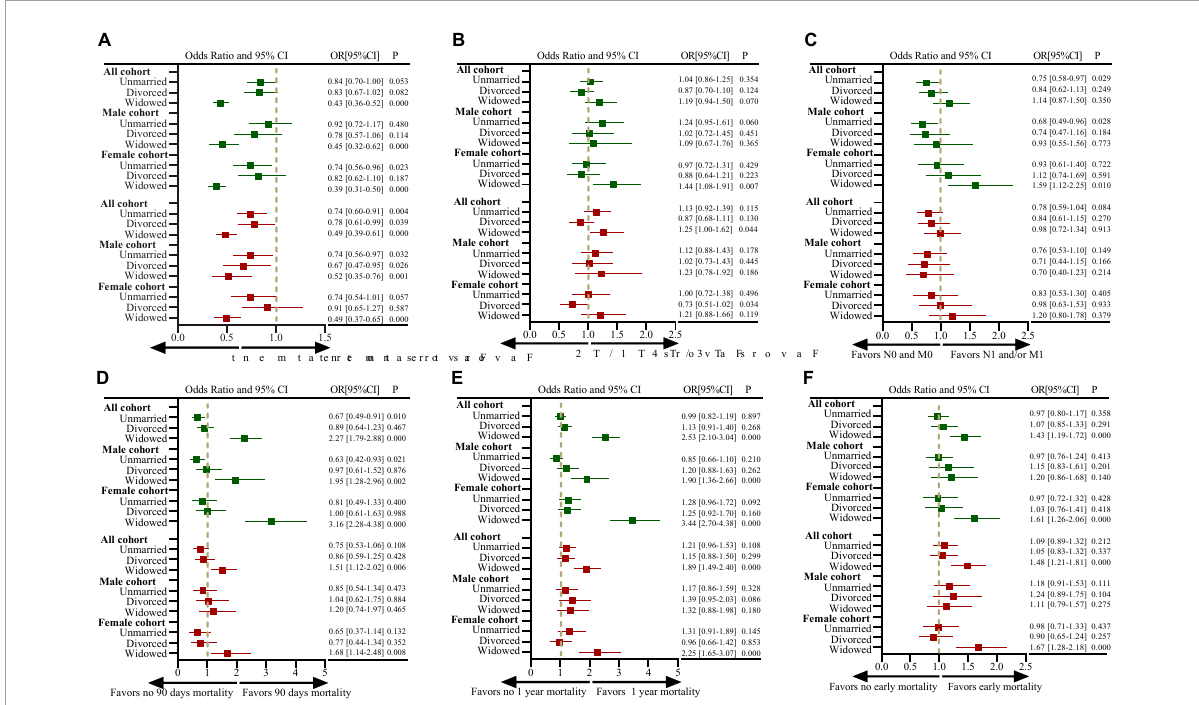
FIGURE3 Forest plots depicting odds ratios (ORs) and 95% confidence intervals (CIs) for examining the association between marital status and (A) the use of definitive surgical treatment (vs. no use of surgical treatment); (B) presentation with T3/T4-stage disease (vs. T1/T2-stage disease); (C) presentation with N1- and/or M1-stage disease (vs. N0- and M0-stage disease); (D) 90-day mortality (vs. > 90-day mortality); (E) 1-year mortality (vs. > 1-year mortality); (F) early mortality. ORs for the measure of use of definitive surgical treatment are adjusted for covariables of year at diagnosis, age at diagnosis, sex, race, median household income, residence, site of tumors, tumor grade, histological features, previous tumor history, T staging, N staging and M staging; ORs for the measure of TNM staging are adjusted for covariables of year at diagnosis, age at diagnosis, sex, race, median household income, residence, site of tumors, tumor grade, histological features, previous tumor history (all analyses were based on the SEER data, excluding cases with missing TNM stage information); ORs for the measure of 90-day and 1-year mortality are adjusted for covariables of year at diagnosis, age at diagnosis, sex, race, median household income, residence, site of tumors, tumor grade, histological features, previous tumor history, T staging, N staging, M staging, surgical treatment, radiation therapy, and chemotherapy; ORs for the measure of early mortality using ordered logistic regression analysis are adjusted for covariables of year at diagnosis, age at diagnosis, sex, race, median household income, residence, site of tumors, tumor grade, histological features, previous tumor history, T staging, N staging, M staging, surgical treatment, radiation therapy and chemotherapy. The “sex” variable was not included in the analysis of male and female subgroups. The dark green color represents the results of univariate analysis, and the brown color represents the results of multivariate analysis.